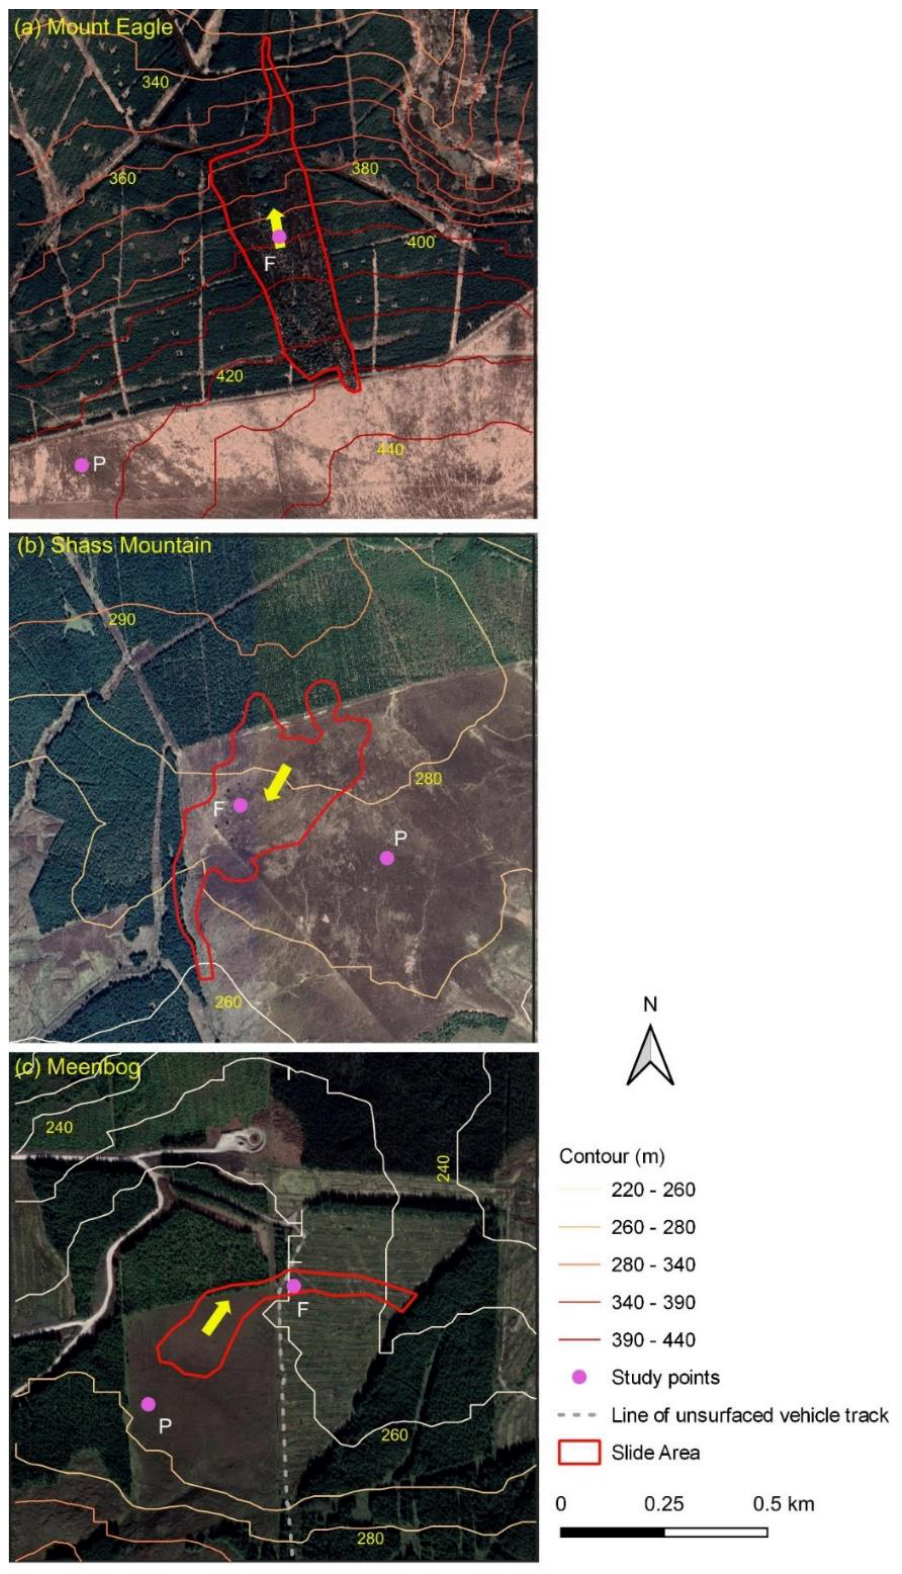
Figure 2. Google Earth aerial images (pre-failure) of the Mount Eagle, Shass Mountain (RPS 2020; see also Figures 9 and 10) and Meenbog study sites with superposed contours (10 m interval). Dark green areas are forestry plantations and light brown areas are mostly blanket bog. For each site, the red polygon outlines the area of peat failure and the yellow arrow indicates the direction of sliding. Also shown are the locations of the selected RVSM examples of peatland outside the failure area (P) and within the failure area